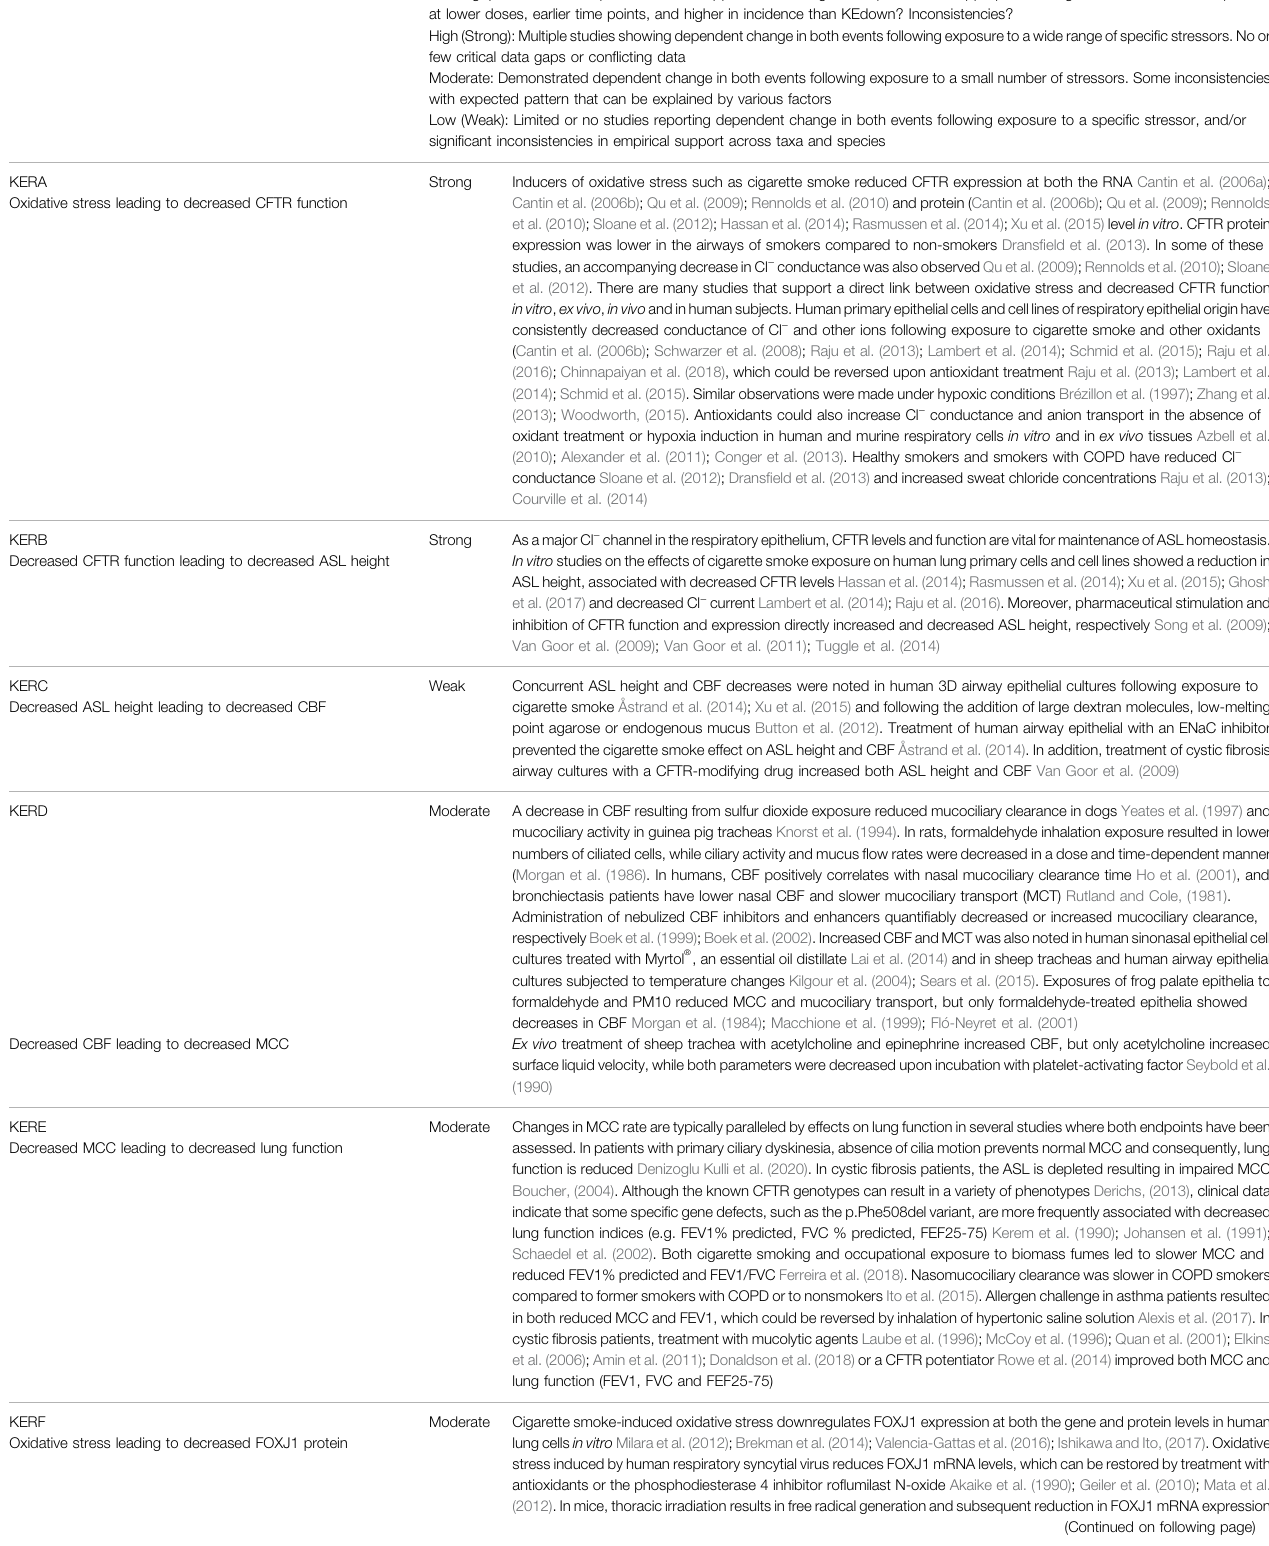
TABLE 1 | Empirical evidence for key event relationships (KER). KER De fi ningquestion:DoesempiricalevidencesupportthatachangeinKEupleadstoanappropriatechangeinKEdown?DoesKEupoccur at lower doses, earlier time points, and higher in incidence than KEdown? Inconsistencies? High(Strong):Multiplestudiesshowingdependentchangeinbotheventsfollowingexposuretoawiderangeofspeci fi cstressors.Noor few critical data gaps or con fl icting data Moderate: Demonstrated dependent change in both events following exposure to a small number of stressors. Some inconsistencies with expected pattern that can be explained by various factors Low (Weak): Limited or no studies reporting dependent change in both events following exposure to a speci fi c stressor, and/or signi fi cant inconsistencies in empirical support across taxa and species KERA Strong Inducers of oxidative stress such as cigarette smoke reduced CFTR expression at both the RNA Cantin et al. (2006a); Cantinetal. (2006b); Quetal. (2009);Rennoldset al.(2010)andprotein (Cantinet al.(2006b); Quet al.(2009); Rennolds etal.(2010);Sloaneetal.(2012);Hassanetal.(2014);Rasmussenetal.(2014);Xuetal.(2015)level invitro .CFTRprotein expression was lower in the airways of smokers compared to non-smokers Drans fi eld et al. (2013). In some of these studies,anaccompanyingdecreaseinCl − conductancewasalsoobservedQuetal.(2009);Rennoldsetal.(2010);Sloane et al. (2012). There are many studies that support a direct link between oxidative stress and decreased CFTR function invitro , exvivo , invivo andinhumansubjects.Humanprimaryepithelialcellsandcelllinesofrespiratoryepithelialoriginhave consistently decreased conductance of Cl − and other ions following exposure to cigarette smoke and other oxidants (Cantin et al. (2006b); Schwarzer et al. (2008); Raju et al. (2013); Lambert et al. (2014); Schmid et al. (2015); Raju et al. (2016); Chinnapaiyan et al. (2018), which could be reversed upon antioxidant treatment Raju et al. (2013); Lambert et al. (2014);Schmidetal.(2015).SimilarobservationsweremadeunderhypoxicconditionsBrézillonetal.(1997);Zhangetal. (2013); Woodworth, (2015). Antioxidants could also increase Cl − conductance and anion transport in the absence of oxidant treatment or hypoxia induction in human and murine respiratory cells in vitro and in ex vivo tissues Azbell et al. (2010); Alexander et al. (2011); Conger et al. (2013). Healthy smokers and smokers with COPD have reduced Cl − conductance Sloane et al. (2012); Drans fi eld et al. (2013) and increased sweat chloride concentrations Raju et al. (2013); Courville et